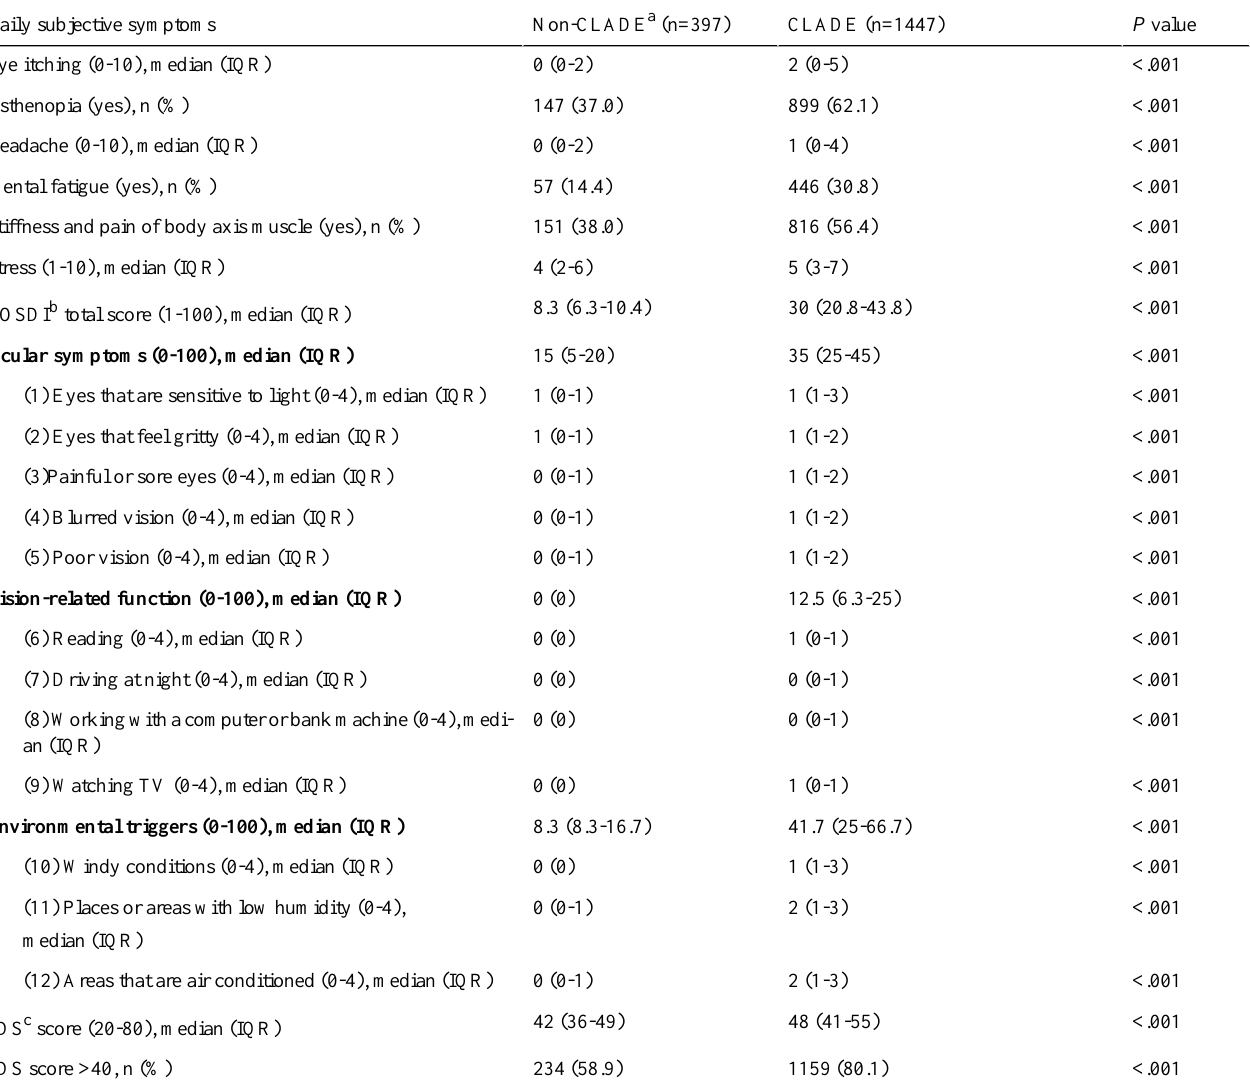
Table 1. Subjective symptoms of contact lens–associated dry